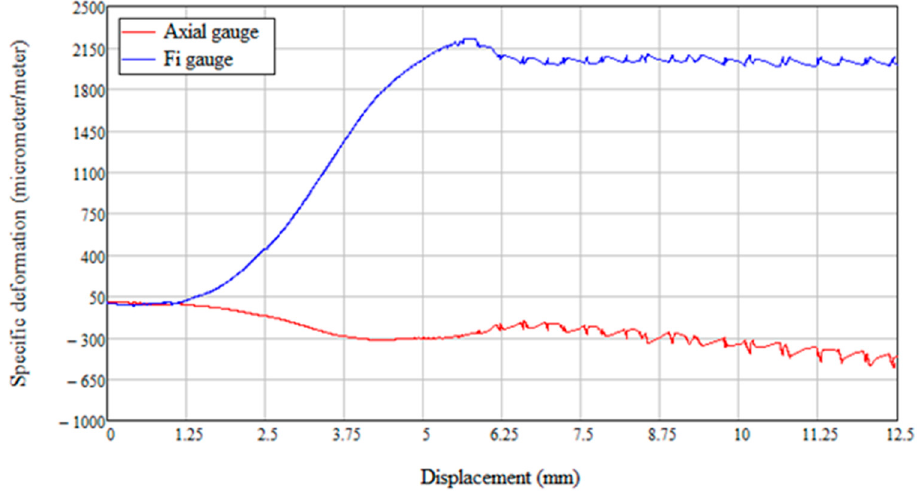
Figure 10. Specific deformations on the axial direction and the circumference in the case of oil-free assembly.